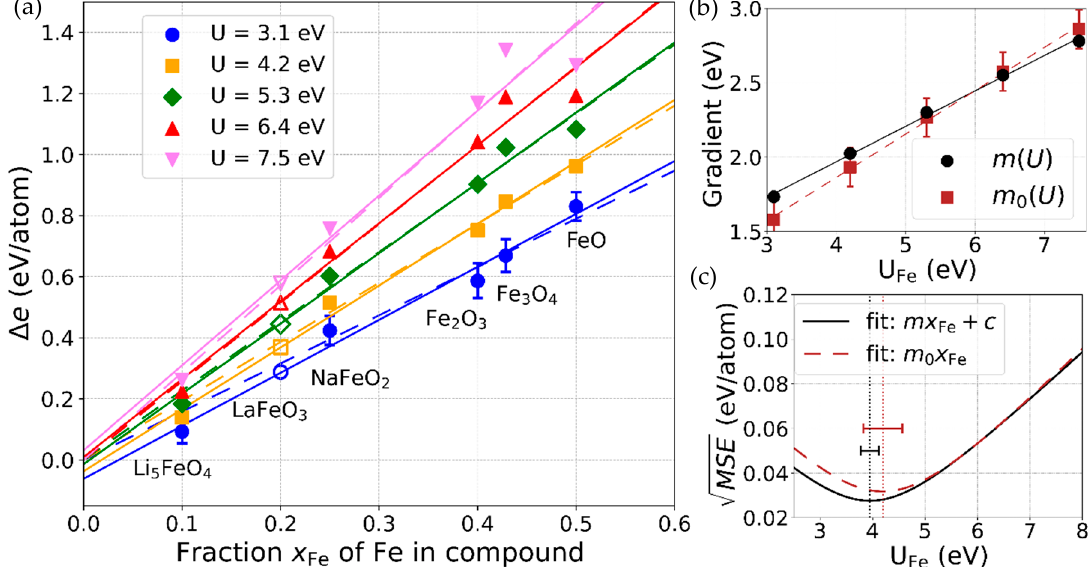
Figure 2. ( a ) : Comparison of the calculated data for different U values with the experimental data. Symbols: energy differences ∆𝑒 between formation energies calculated with DFT and DFT+ U and experimental values for different compounds containing Fe and for different values of U Fe . The error bars shown exemplarily for the values for U Fe = 3.1 eV originate from the uncertainty in the oxygen correction value 𝑏 , described in Section 3.1. They are not to be understood in a statistical way but meant as upper and lower limits between which all of the data points consistently shift if 𝑏 is varied between −∆𝑏 and +∆𝑏 . Data points represented by filled symbols were fitted by linear functions ∆𝑒 (cid:3022)(cid:2916)(cid:2919)(cid:2930) (𝑥 (cid:2890)(cid:2915) ) = 𝑚(𝑈)𝑥 (cid:2890)(cid:2915) + 𝑐(𝑈) (solid lines) and ∆𝑒 (cid:3022)(cid:2916)(cid:2919)(cid:2930),(cid:2868) (𝑥 (cid:2890)(cid:2915) ) = 𝑚 (cid:2868) (𝑈)𝑥 (cid:2890)(cid:2915) (dashed lines). The open symbols for LaFeO 3 were not included in the fitting. ( b ): Slopes 𝑚(𝑈) and 𝑚 (cid:2868) (𝑈) . Again, the error bars depict the upper and lower limits of the values. They result from the limits of the data points in the graph in the left panel. ( c ): Square root of the mean square errors (MSE) between the fit function ∆𝑒 (cid:3022)(cid:2916)(cid:2919)(cid:2930) (𝑥 (cid:2890)(cid:2915) ) ( ∆𝑒 (cid:3022)(cid:2916)(cid:2919)(cid:2930),(cid:2868) (𝑥 (cid:2890)(cid:2915) ) ) and the data points ∆𝑒 . The U values leading to the MSE minima are displayed by dashed vertical lines at 3.95 eV ( ∆𝑒 (cid:3022)(cid:2916)(cid:2919)(cid:2930) ) and 4.20 eV ( ∆𝑒 (cid:3022)(cid:2916)(cid:2919)(cid:2930),(cid:2868) ), together with bars encompassing again the range of values that result when the oxygen correction is consistently varied between 𝑏 − ∆𝑏 and 𝑏 + ∆𝑏 .